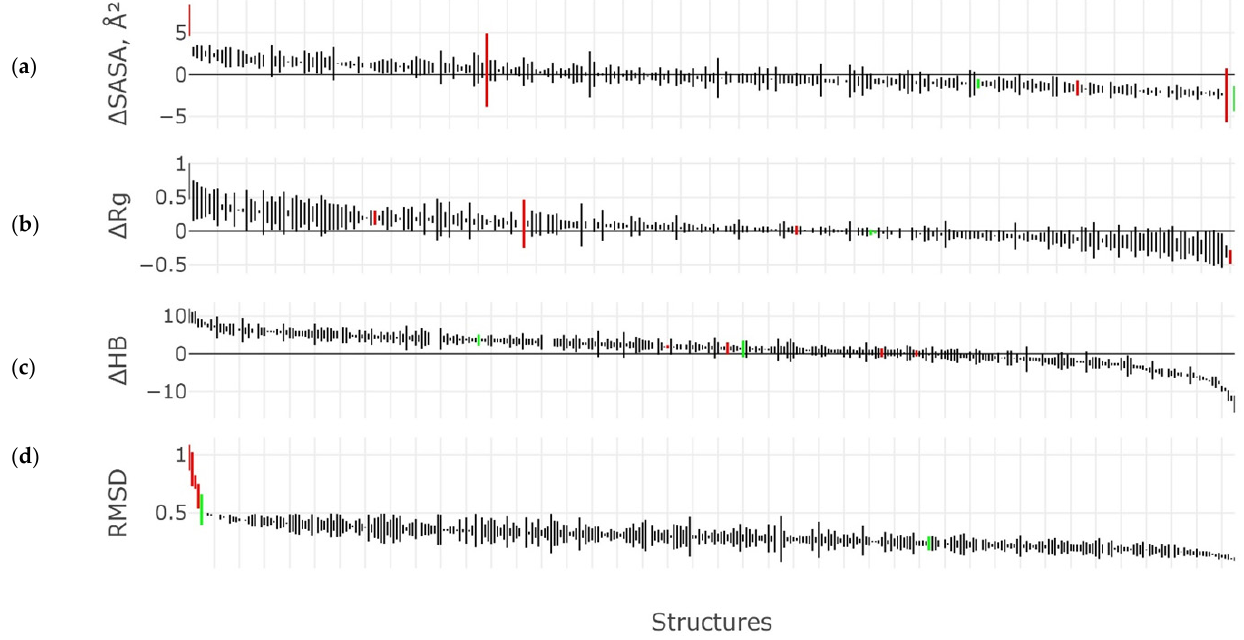
Figure 5. Comparative analysis of MD geometric characteristics for 330 structures of 3 β -corners of experimental structures (exp) versus structures after MD (data are shown in three technical replicates). Distribution of ( a ) solvent-accessible surface area (SASA, Å 2 ); ( b ) gyration radius (Rg); ( c ) the number of hydrogen bonds (HB); ( d ) RMSD (nm). All the structures involved in the experiment were deposited along the OH axis. The order of structures along the OH axis was generated separately for each characteristic and arranged in incremental order (from maximum to minimum). Red lines indicate measurements for the structures of the control set (negative control); green lines indicate measurements of selected motifs within a whole protein molecule; black lines designate measurements of characteristics for 3 β -corners of the target dataset.